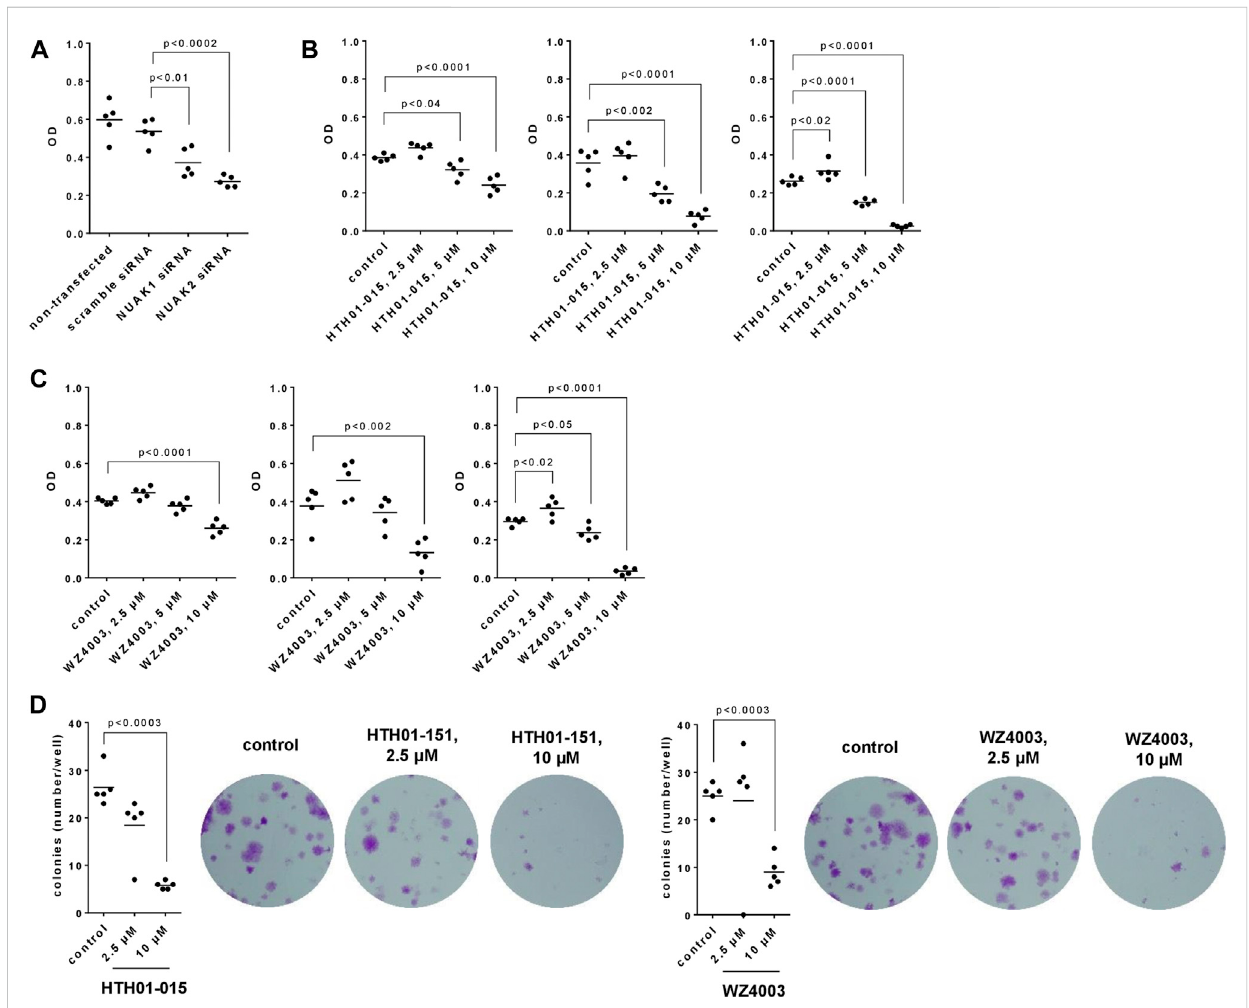
FIGURE 5 Effects of NUAK silencing, HTH01-015 and WZ4003 on viability and colony formation of WPMY-1 cells. Viability was determined by CCK-8 assays (A – C) , and cell growth by colony formation assay (D) , 24 h after transfection with scramble siRNA or isoform-speci fi c NUAK siRNAs (A) , 24-72 h after addition of HTH01-015, WZ4003 or solvent to controls (B,C) or 13 days after addition of HTH01-015, WZ4003 or solvent to controls (D) . Shown are scatterplotsincludingallsinglevaluesfromeachindependentexperimenttogetherwith p valuesfromone-wayANOVAwithTukey ’ stestin (A) ,and from one-way ANOVA with Dunnett ’ s test in (B – D) , and representative experiments from colony formation